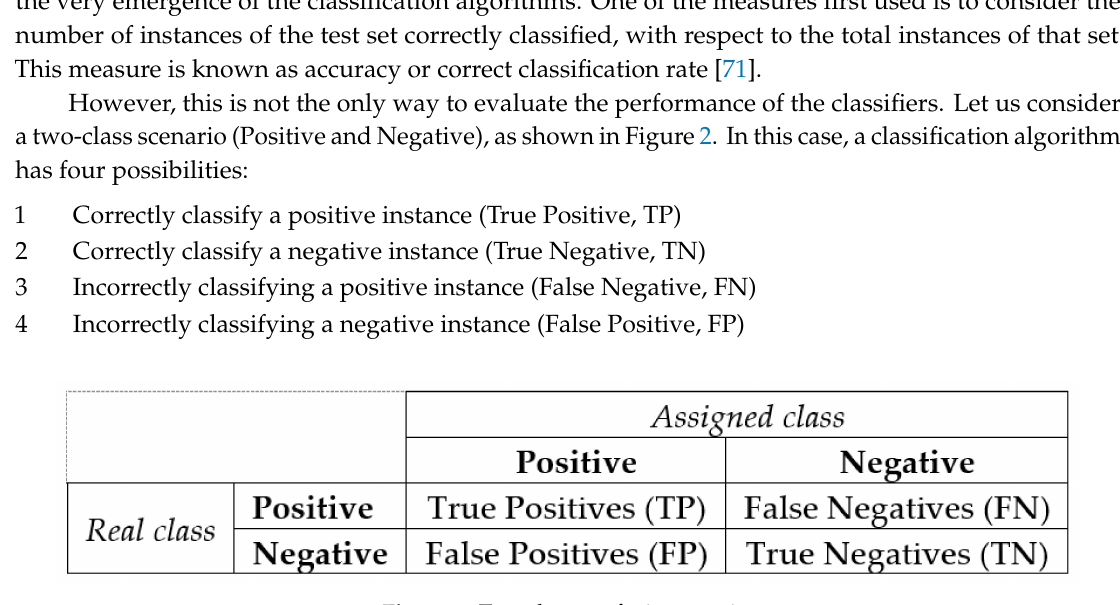
Figure 2. Two class confusion matrix.